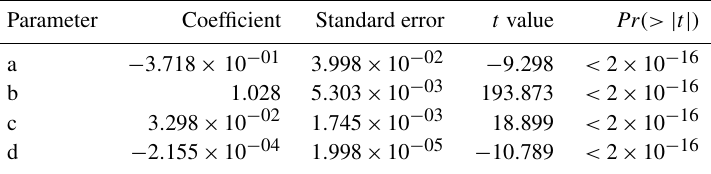
Table F1. Summary of the linear regression analysis to determine the wind speed above the canopy based on previous measured data from the MRI plot and the meteorological station in La Selva Biological Station, based on data collected at 30min intervals in both locations from the year